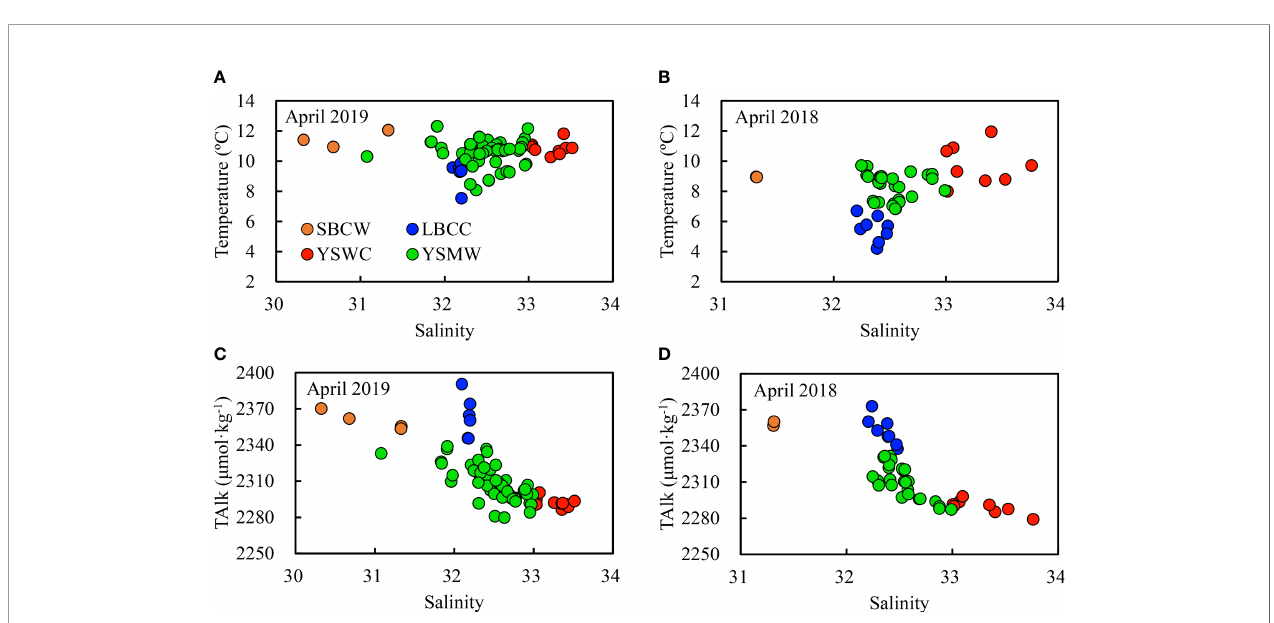
FIGURE 7 | Relationships between water temperature and salinity (A, B) and between TAlk and salinity (C, D) in the SYS in spring. Only surface and bottom-water data were plotted. SBCW, Subei Coastal Water; LBCC, Lubei Coastal Current; YSWC, Yellow Sea Warm Current; YSMW, Yellow Sea Mixed Water. Locations of typical SBCW, LBCC, and YSWC waters observed in April 2019 are shown in Figure 1B